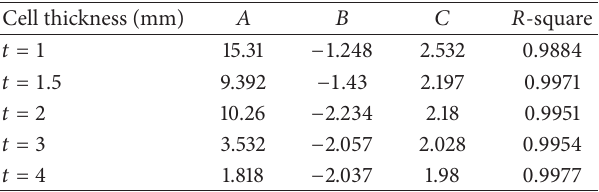
Table 1: Parameters of the function expression.